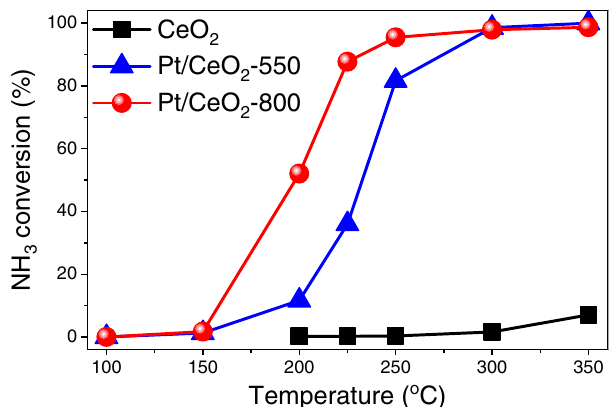
Fig.7|NH 3 oxidationactivity. NH 3 oxidationperformanceonPt/CeO 2 -550andPt/ CeO 2 -800 catalysts as wellasCeO 2 support (Reaction condition: [NH 3 ]=500 ppm, [O 2 ]=5%, balanced with Ar, WHSV=200,000mL ∙ g cat − 1 ∙ h − 1